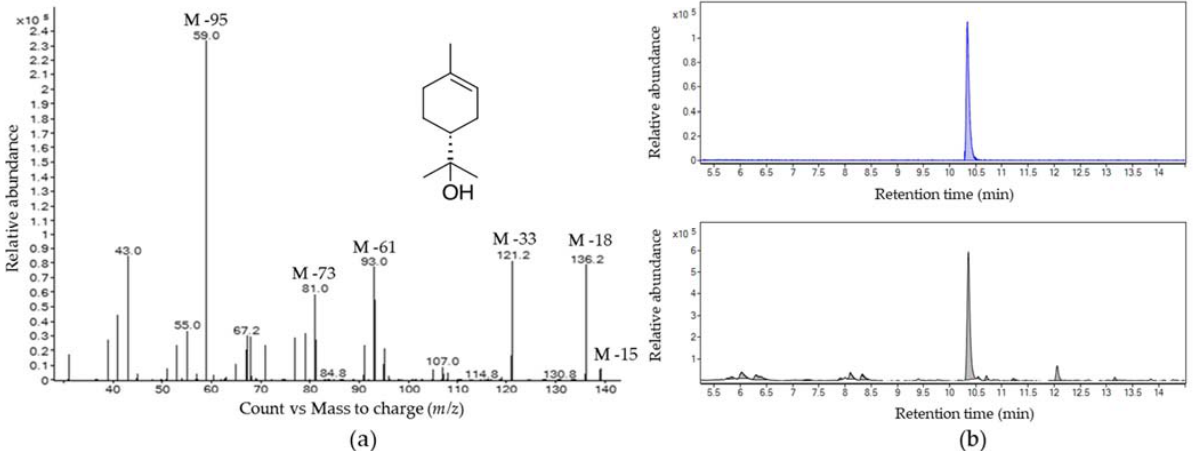
Figure 3. Gas-chromatography-mass spectrometry identification of α -terpineol ( a ), mass spectrum obtained from a chromatographic peak of the volatile blend produced by males feeding on soursop. The matching factor with the library spectrum (NIST 2014) of this metabolite was 95%. ( b ), Retention time comparison between chromatographic peaks of a standard compound (upper chromatogram) and a volatile blend produced by males feeding on soursop (lower chromatogram).